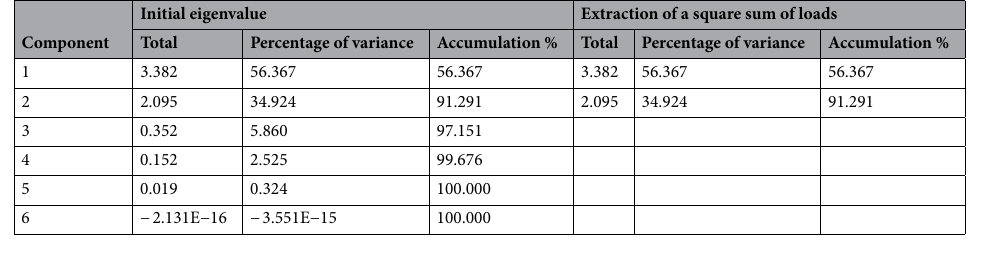
Table 6. Total variance interpretation.